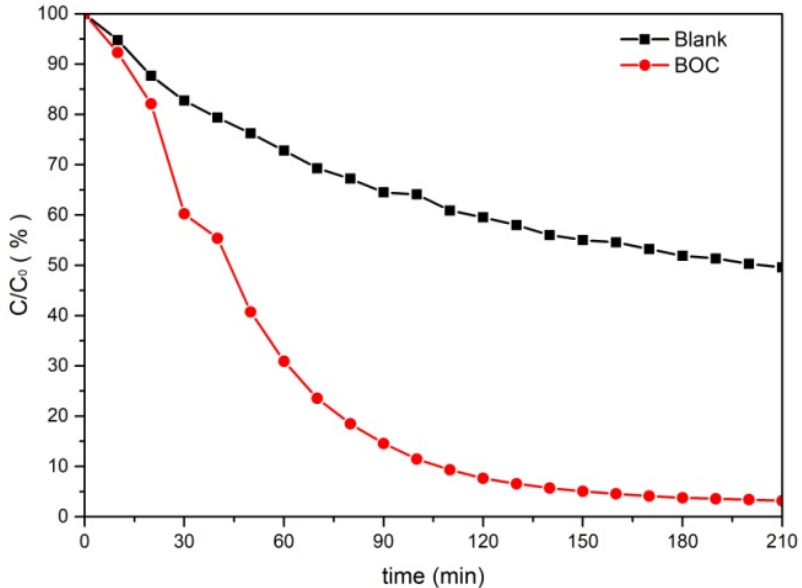
Figure 4. The photocatalytic property of Bi 2 O 2 CO 3 for toluene removal in air. The blank control experiment was performed under light illumination in the absence of catalyst.